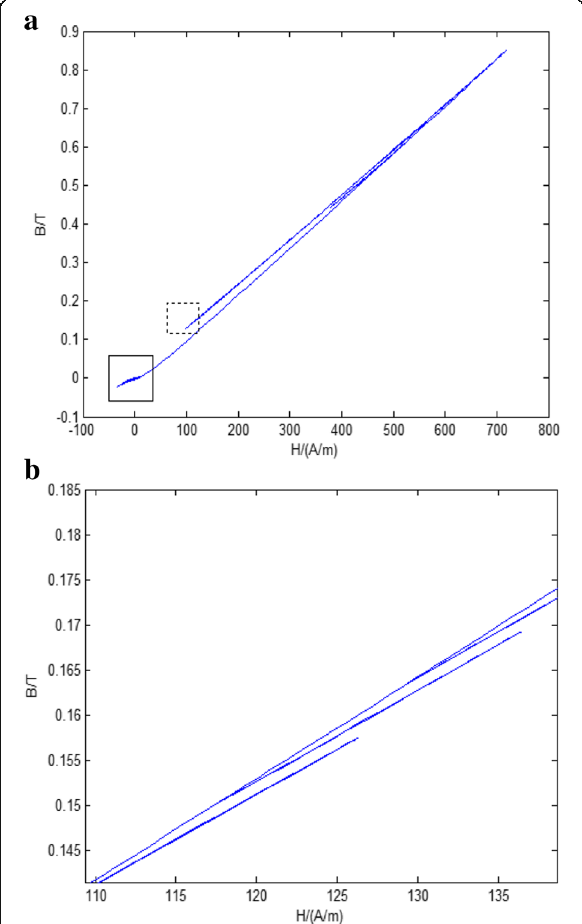
Fig. 20 Air-gapped core magnetization curve. a whole process b ending